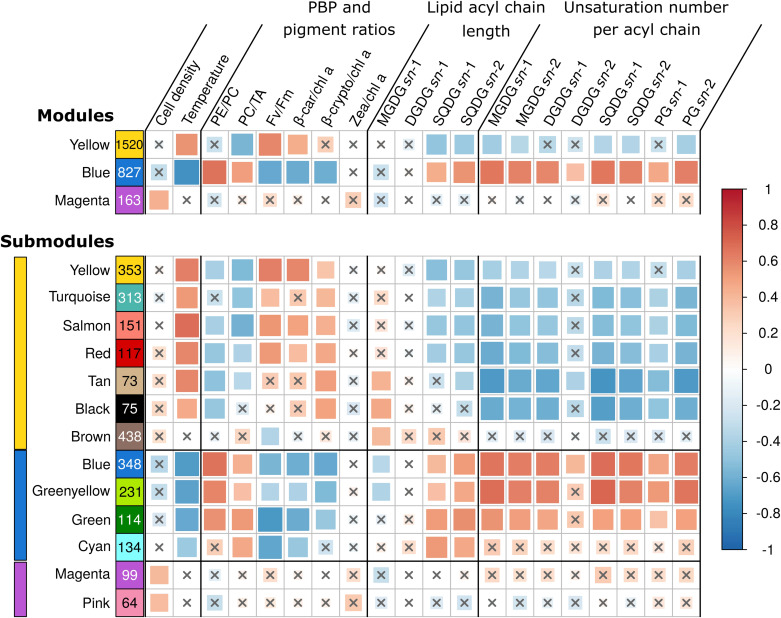
Correlations between WGCNA modules eigengenes and phenotypic traits. Each row represents either a gene module (top four rows) or submodules (bottom 14 rows) and number of genes in the module or submodule are specified in colored rectangles. Colored bars on left hand side indicate the corresponding module. Biophysical parameters are expressed as a percentage of the T0 of each experiment. The color scale reflects the Pearson correlation coefficient (R2). The size of the correlation squares is inversely related to the p-value. Genes that could not be clustered into one of the modules were assigned to the gray module (not shown), and non-significant correlations (Student adjusted p-value > 10–3) are indicated by a cross. PBP, phycobiliprotein; PC, phycocyanin; PE, phycoerythrin; TA, terminal acceptor; FV/FM, PSII maximal photochemical yield; β-car, β-carotene; chl, chlorophyll; β-crypto, β-cryptoxanthin; zea, zeaxanthin; MGDG, monogalactosyldiacylglycerol; DGDG, digalactosyldiacylglycerol; SQDG, sulfoquinovosyldiacylglycerol; PG, phosphatidylglycerol.